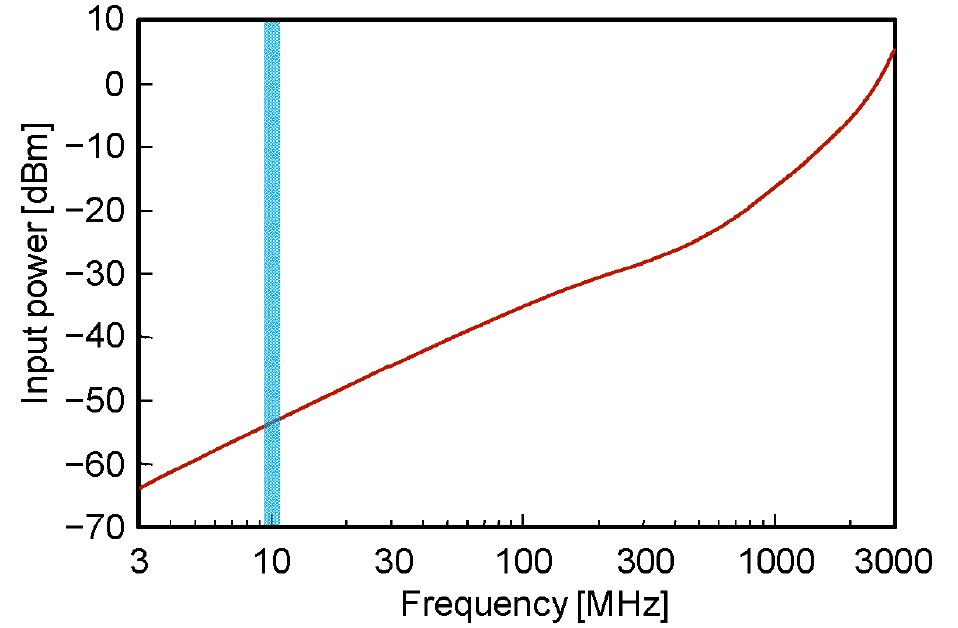
Figure 2. Input power when 1-V input is